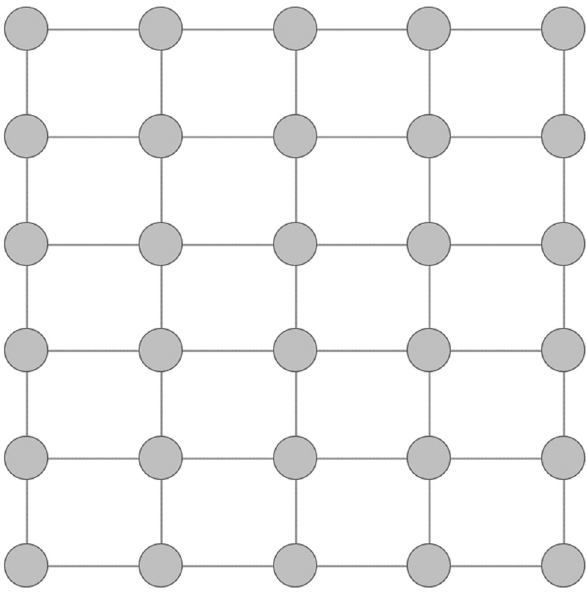
Figure 1: The Cartesian product graph of